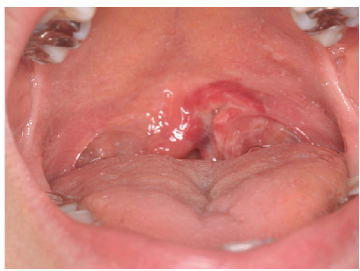
Figure 3: Case 1. The wound after removal of the head of the electric toothbrush.